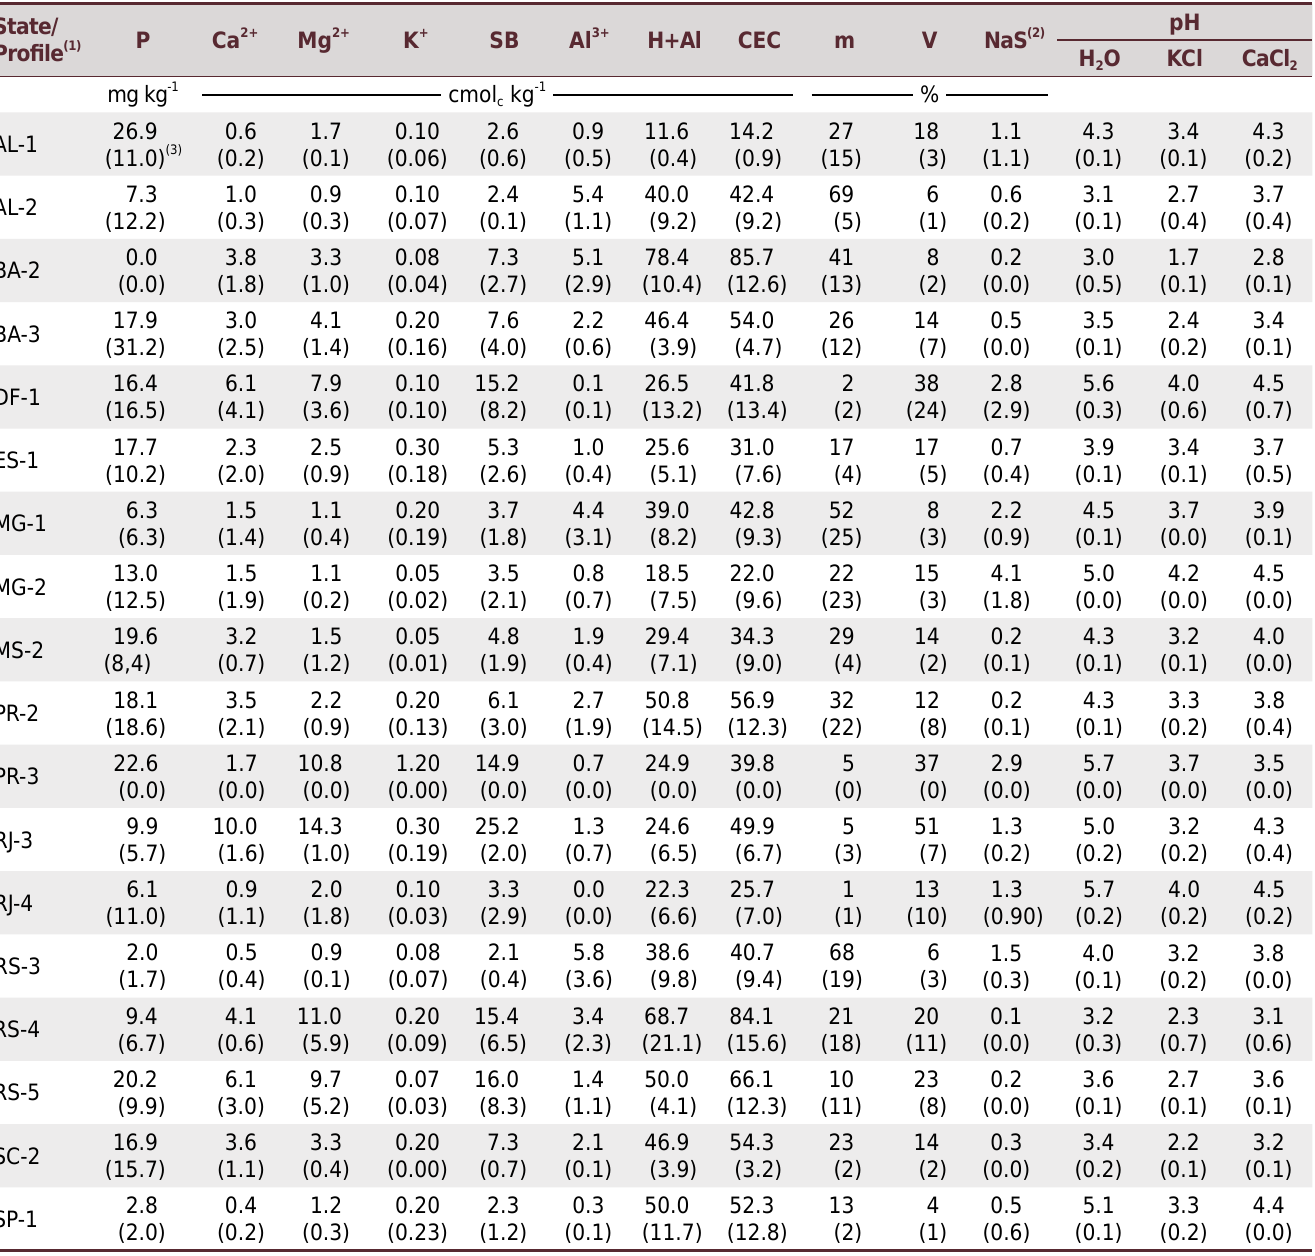
Table 2. Chemical properties of the Organosol profiles